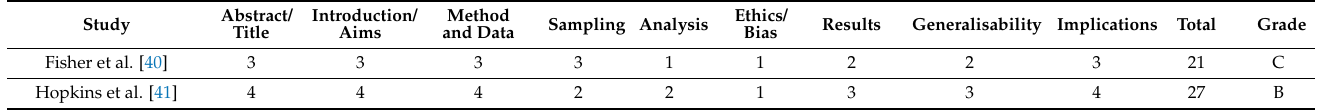
Table 5. Critical appraisal tool—result of the quality assessment for qualitative studies ( n = 2).